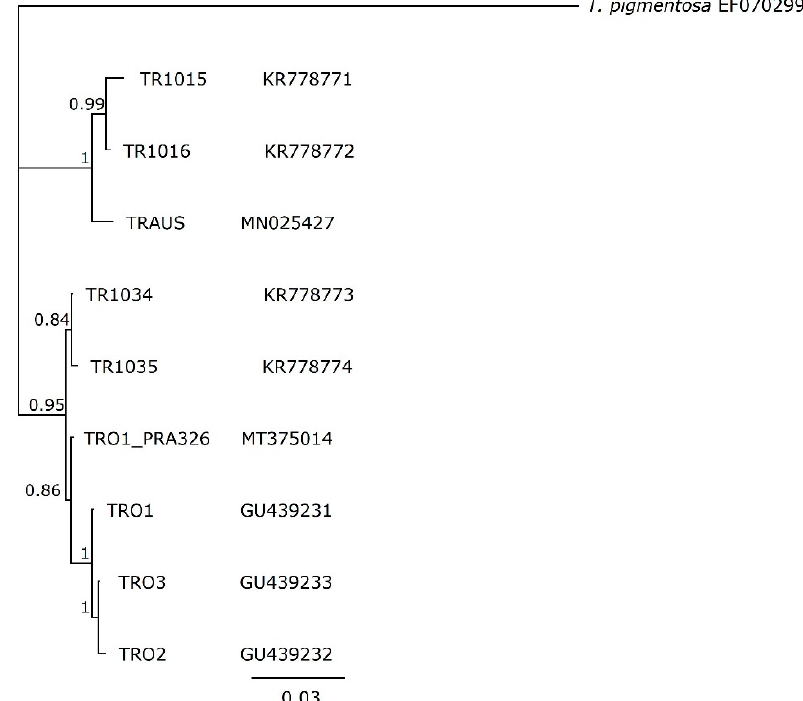
Figure 4. Phylogenetic tree of Tetrahymena rostrata strains based on 1796 bp of the cox 1 genes. A